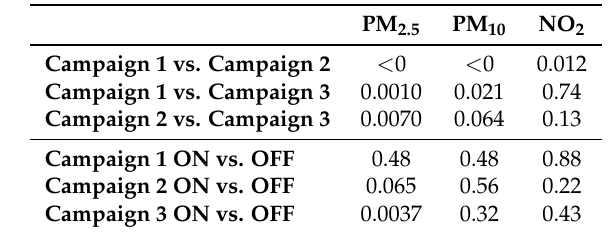
p -values obtained from Wilcoxon–Mann–Whitney test among the different groups. Campaign 1 includes waste removal trucks ( N = 3), Campaign 2 includes hospital vans ( N = 7) and Campaign 3 includes taxis ( N = 4). ON = with in-cabin filtration, OFF = without in-cabin filtration.